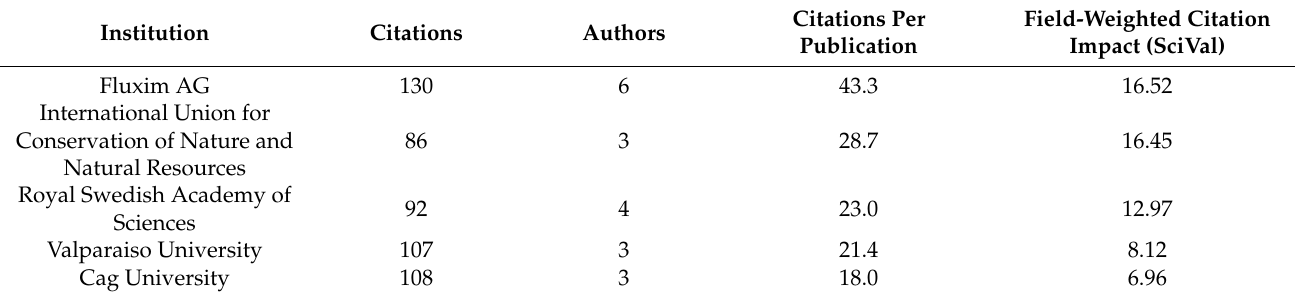
Table 4. Top 5 institutions by number of citations per publication in Scopus on renewable energy, sustainability and the environment in